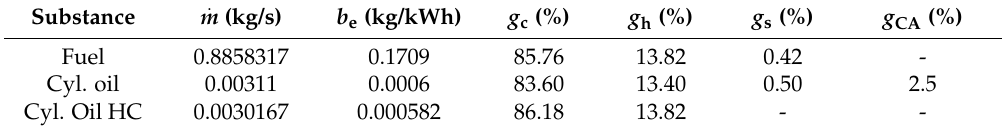
Table 3. Fuel and cylinder oil consumption and mass composition at 100% SMCR, ISO conditions.